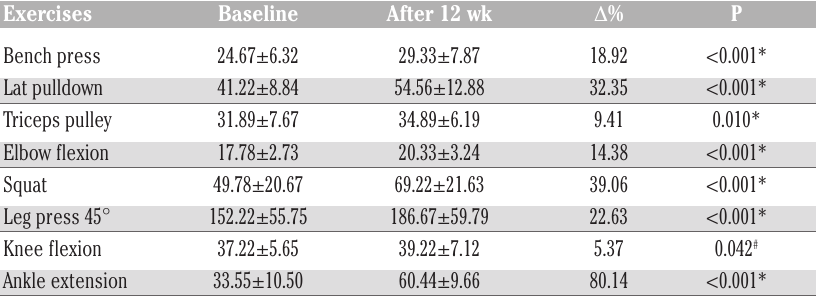
Data are presented as mean ± standard deviation. 1RM, one repetition maximum; n, number of participants. *Significant difference calculated by paired t test, # Significant difference calculated by the Wilcoxon test.